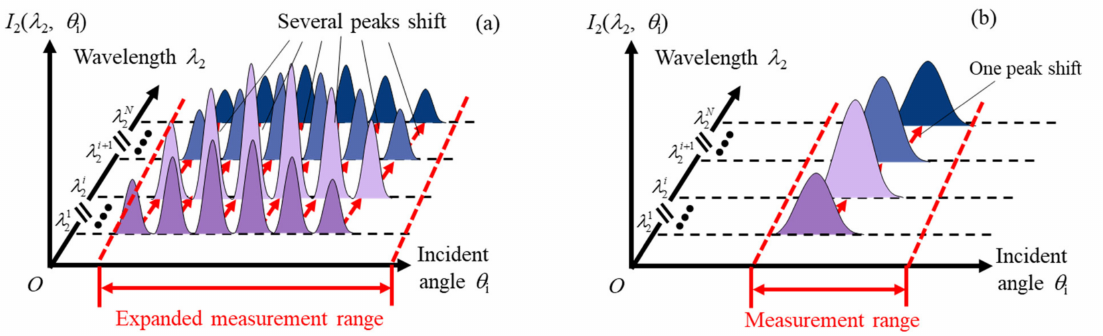
Figure 3. ( a ) The peak shifts of Maker fringe; ( b ) the peak shift nearing the phase-matching